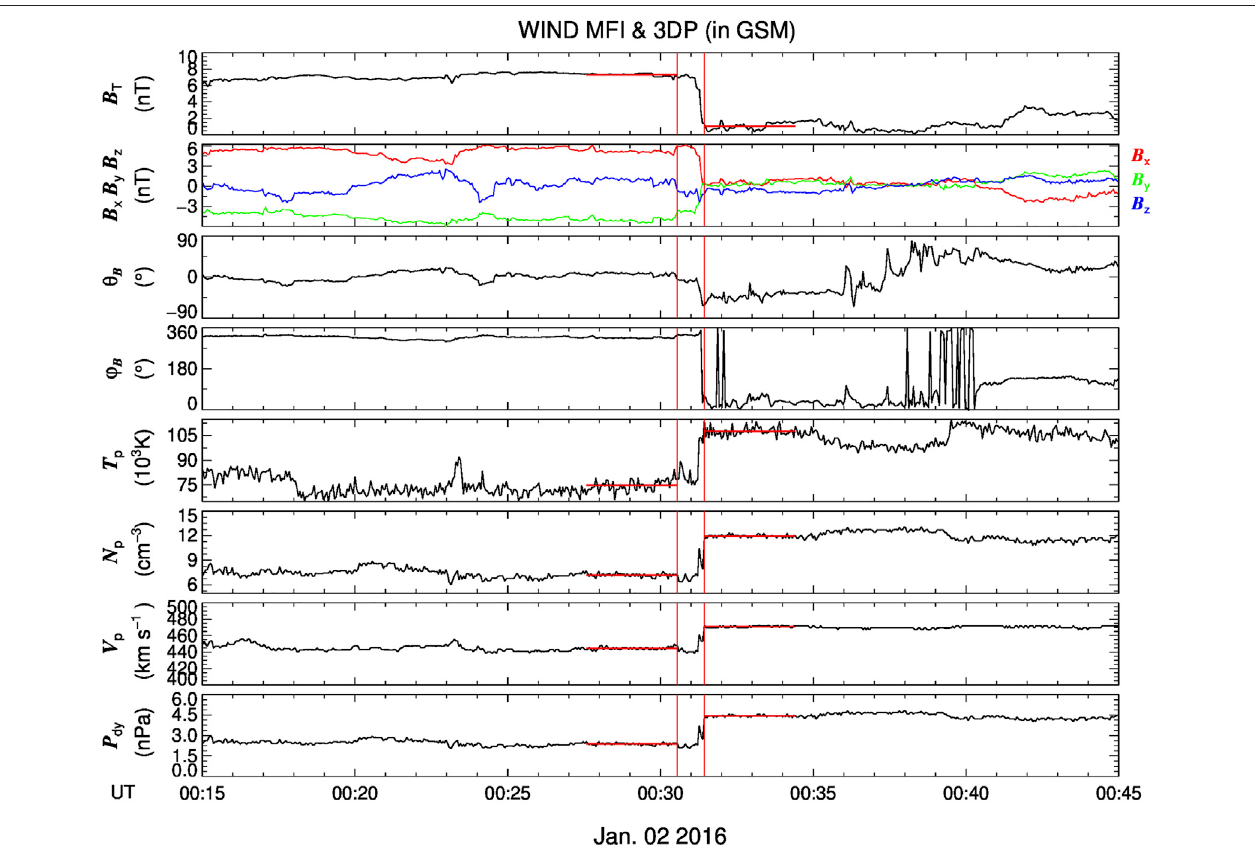
FIGURE 1 | One typical DPP event in the solar wind observed by WIND on January 2, 2016. The boundaries of the DPP transition region are marked by the red vertical lines, and the transverse lines before and after the DPP transition region denote DPP ’ s upstream and downstream regions. The panels from top to bottom are: magnetic- fi eld magnitude, the three components (x, y, z) of the magnetic fi eld in Geocentric Solar Magnetospheric (GSM) coordinates, magnetic- fi eld latitude angle, magnetic- fi eld azimuthal angle, proton temperature, proton density, proton bulk speed, and solar wind dynamic pressure,